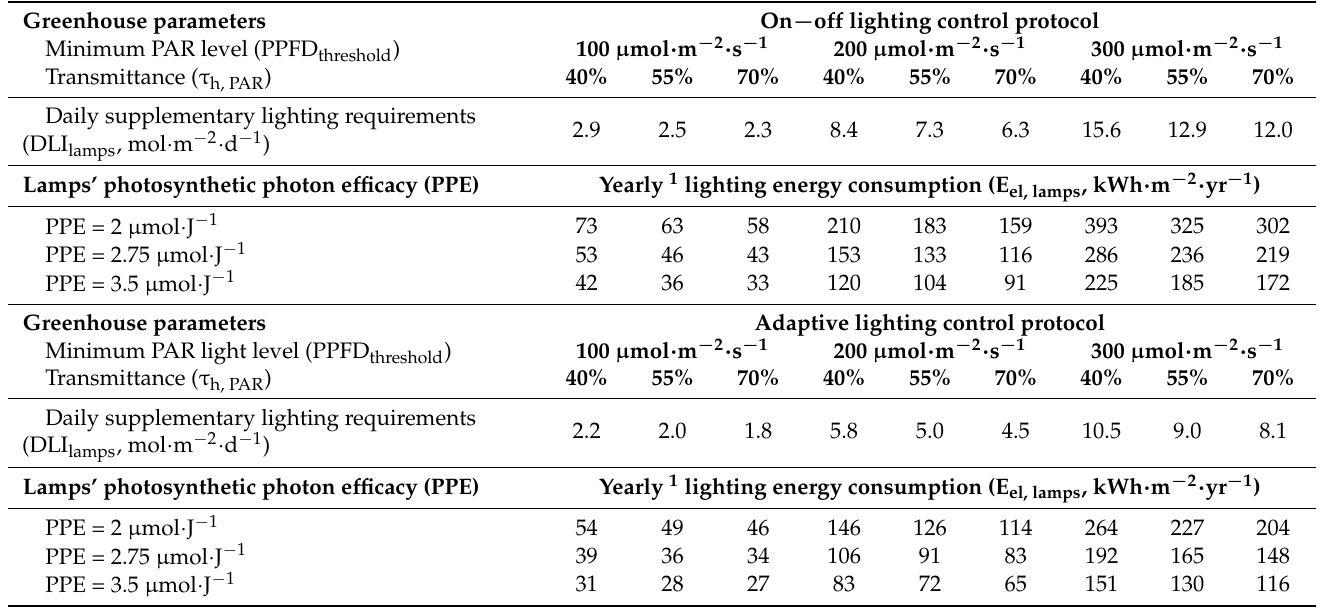
Table 4. Parametric comparison of the estimated daily supplementary lighting and corresponding electric energy consump- tion for a 181 days greenhouse cultivation from February to May and from August to October in Borlänge, Sweden. Greenhouse parameters